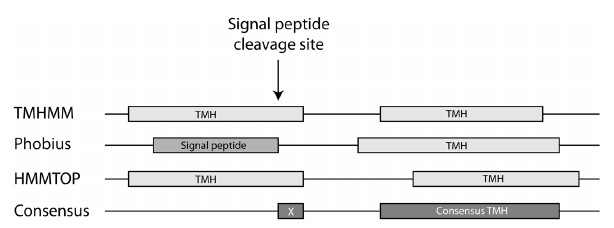
FIGURE 2 | Consensus transmembrane helix prediction module. A consensusTMH should be predicted by at least two tools. Signal peptides frequently result in false-positiveTMH predictions and are removed with consensusTMH predictions.